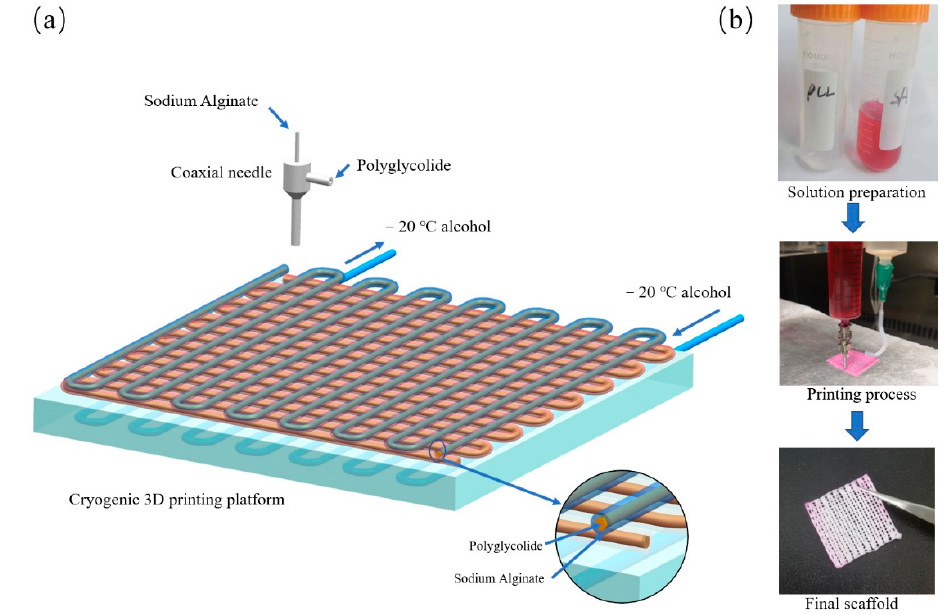
Figure 1. ( a ) The schematic diagram of cryogenic coaxial printing with PCL as the shell and SA as the core; ( b ) photographs of materials, process, and final 3D scaffold.